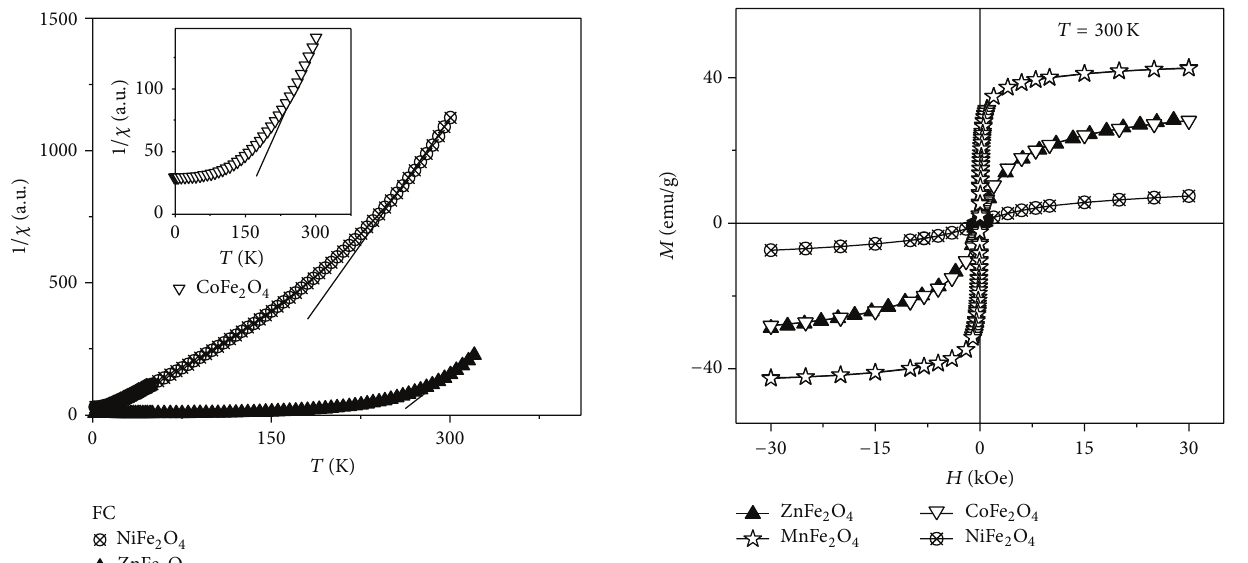
Figure 7: The magnetization 𝑀 versus magnetic field 𝐻 depen- dences for the NPs of zinc, manganese, cobalt, and nickel spinel ferrites. The magnetization curves were obtained at 300